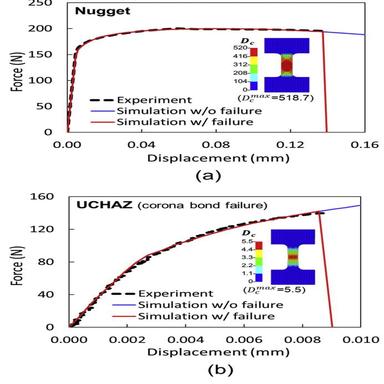
Calculated force-displacement curves for the miniature tensile test and the distribution of Dc at the fracture point. (a) Nugget; (b) UCHAZ.